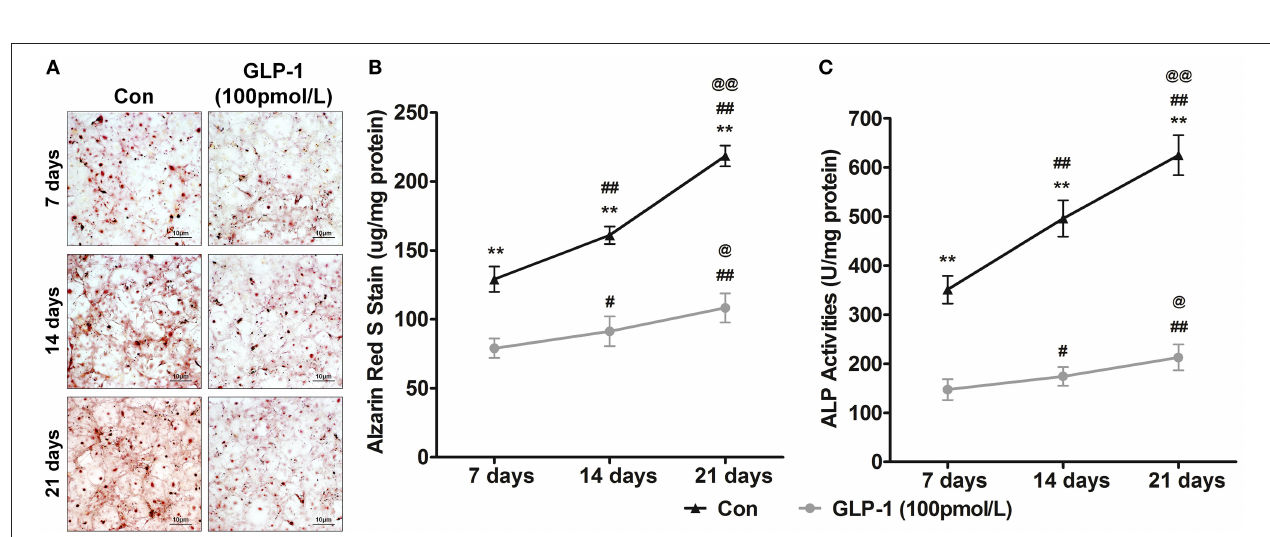
FIGURE 4 | GLP-1 postpones the age-induced mineralization of AVICs. To determine the effect of GLP-1 on age-induced mineralization in AVICs, primary AVICs were cultured for 7, 14, and 21 days in osteogenic medium plus GLP-1 (100 pmol/L) or not. The group without the GLP-1 treatment was used as a control (Con). (A) Alizarin Red S stained the calcification cells, and the pictures were taken using Image-Pro Plus 6.0. Alizarin Red S staining is shown at 400 × magnification. (B) Quantification of Alizarin Red S staining. (C) Quantification of ALP activation in AVICs. The dye was extracted and quantified as described in the Methods section ( n = 6, mean ± SD, ** P < 0.01 compared with Con; # P < 0.05, ## P < 0.01 compared with 7-day culture; @ P < 0.05, @@ P < 0.01 compared with 14-day